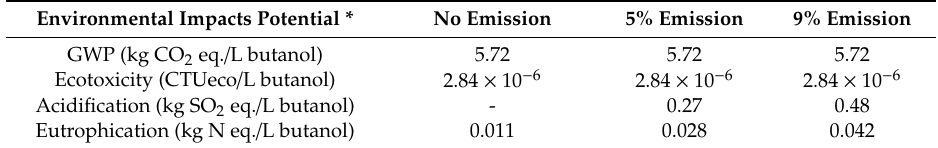
Table 10. Environmental impacts comparison from LMAA pretreatment model with varying anhydrous ammonia emitted.